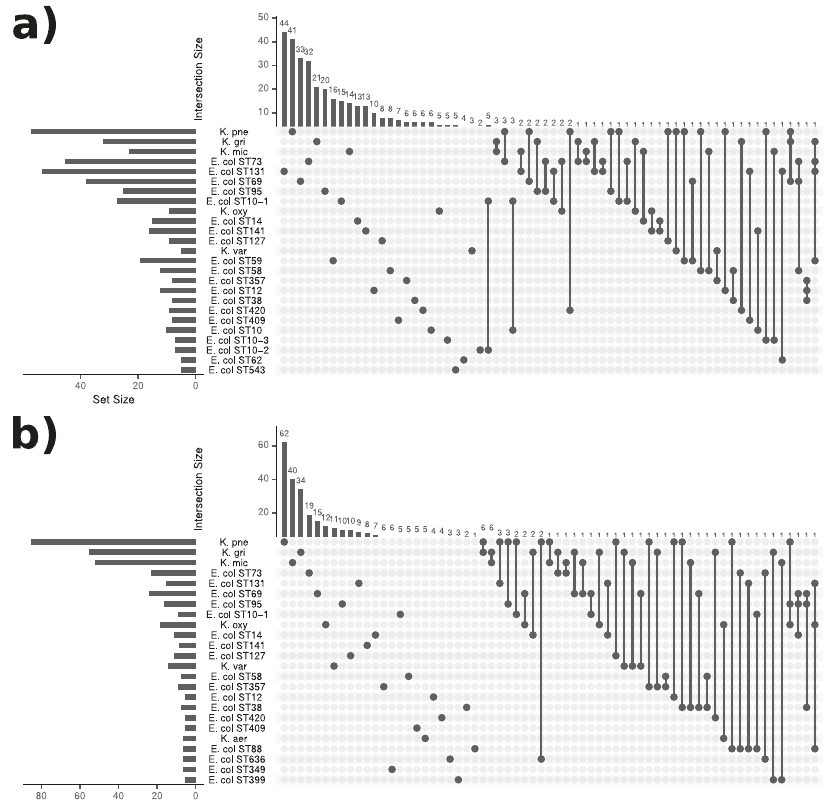
Fig. 3 | UpSet plot showing coexistence of E. coli lineages with Klebsiella species. The plot displays the number of times the E. coli lineages and various Klebsiella species were found either alone (single dots) or together in a sample (connected dots), and at least fi ve times. Data are shown in ( a ) for the vaginal